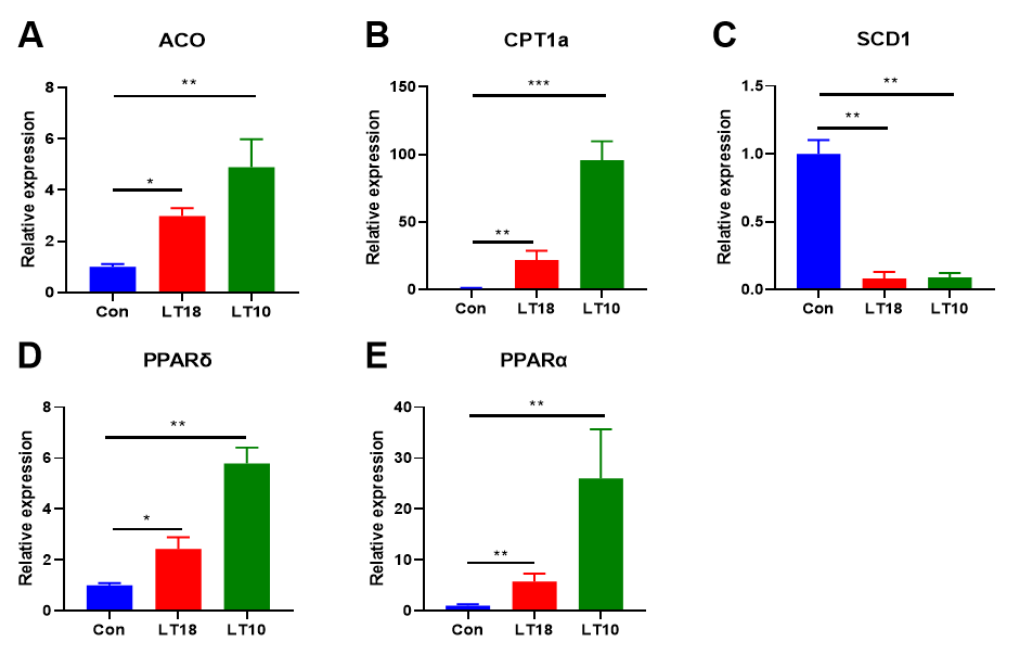
Figure 6. Expression of PPARs signaling related genes in Freshwater drums liver induced by 2 days cold stress ( n = 9): ( A ) acyl-coenzyme A oxidase, ACO; ( B ) carnitine palmityl -transferase 1A, CPT1a; ( C ) stearoylcoa desaturase-1, SCD1; ( D ) PPAR delta, PPARδ; ( E ) PPAR alpha, PPARα. Asterisk represents the statistical difference (*, p <0.05; **, p < 0.01; ***, p < 0.001).